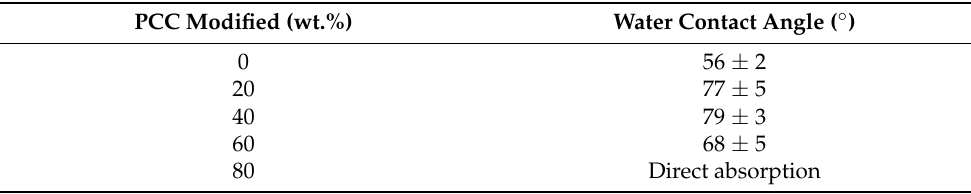
Table 2. Water contact angle of composite films with modified PCC. PCC Modified (wt.%)